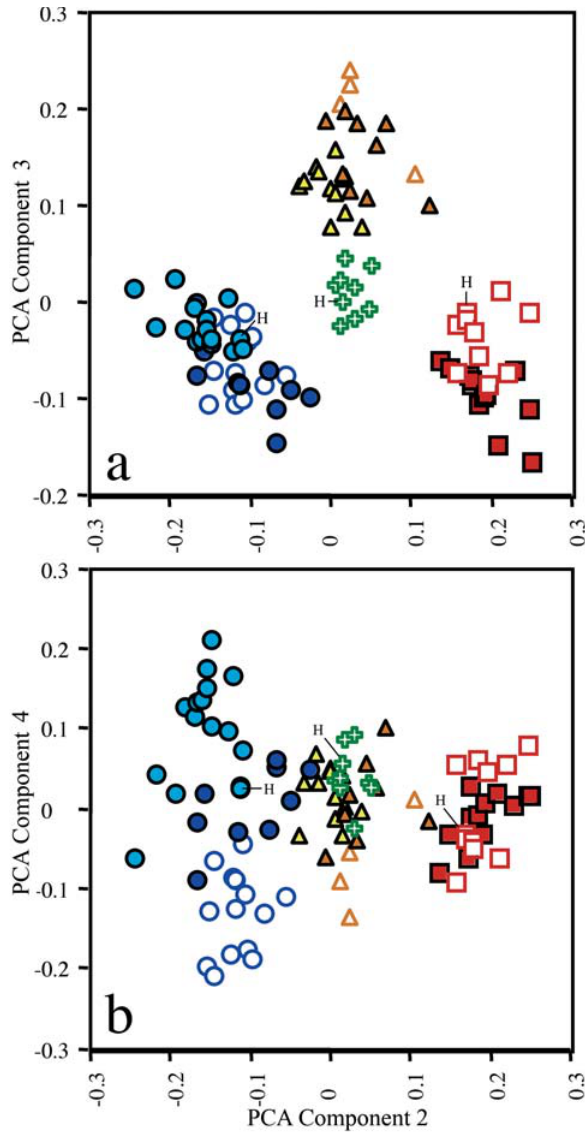
Fig. 3. Scatterplots of scores factored from covariance matrix of 34 log-transformed morphometric variables on principal components axes II vs. III (a) and II vs. IV (b) for 5 species of Leptodoras : L. nelsoni (open squares), L. acipenserinus (shaded squares), L. rogersae (open crosses), L. cataniai (light shaded circles), L. cf. cataniai Amazon form (dark shaded circles), L. cf. cataniai Nanay form (open circles), L. linnelli Essequibo (dark shaded triangles), L. linnelli eastern Guyana Shield (open triangles), L. linnelli Orinoco (light shaded tri- angles). Holotypes of new species denoted with “H”; mea- sured specimens denoted with asterisk in material